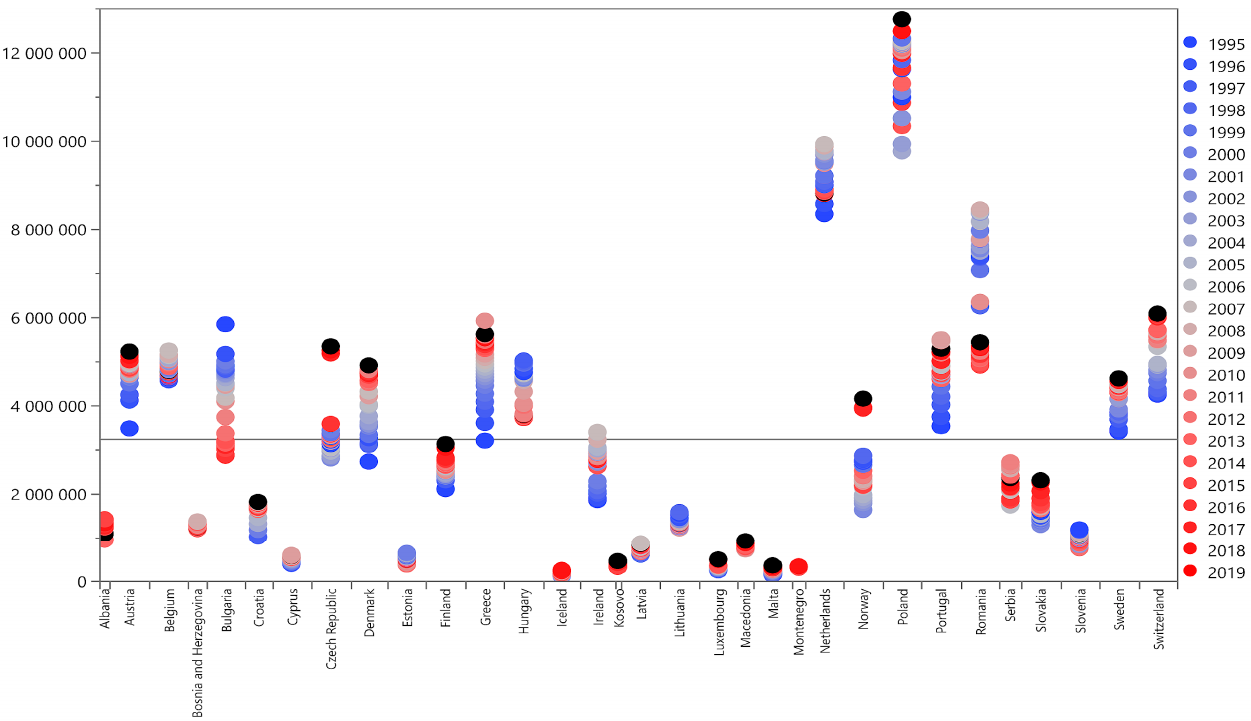
Figure 8. Municipal waste production in the EU with production of up to 13 million tons per year.